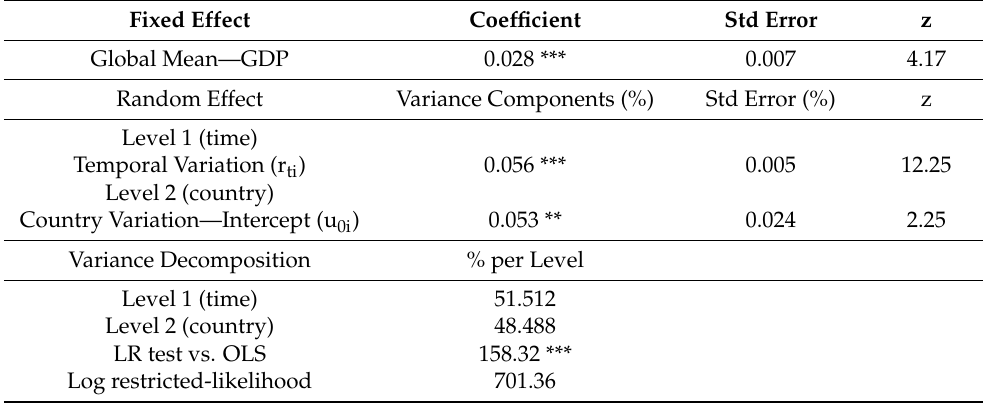
Table 5. Variance Decomposition—Null